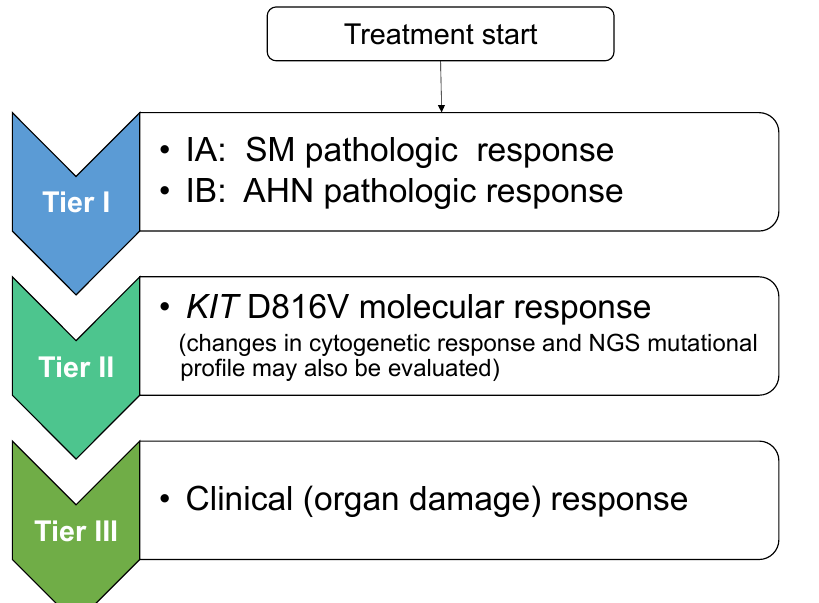
Figure 1. Proposal for Tiered Response Criteria in Advanced Systemic Mastocytosis. After initiation of treatment, adjudication of response is separated into three sequential tiers. Evaluation commences with tier I: SM pathologic response (and if an SM with an associated hematologic neoplasm (SM-